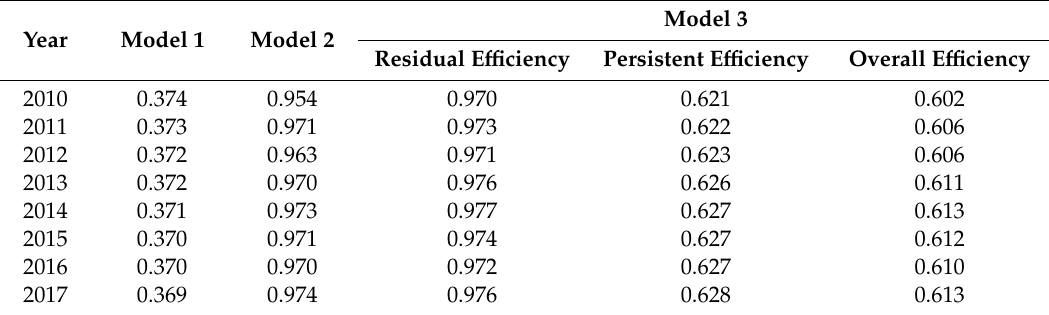
Table 6. Development of mean energy e ffi ciency over time